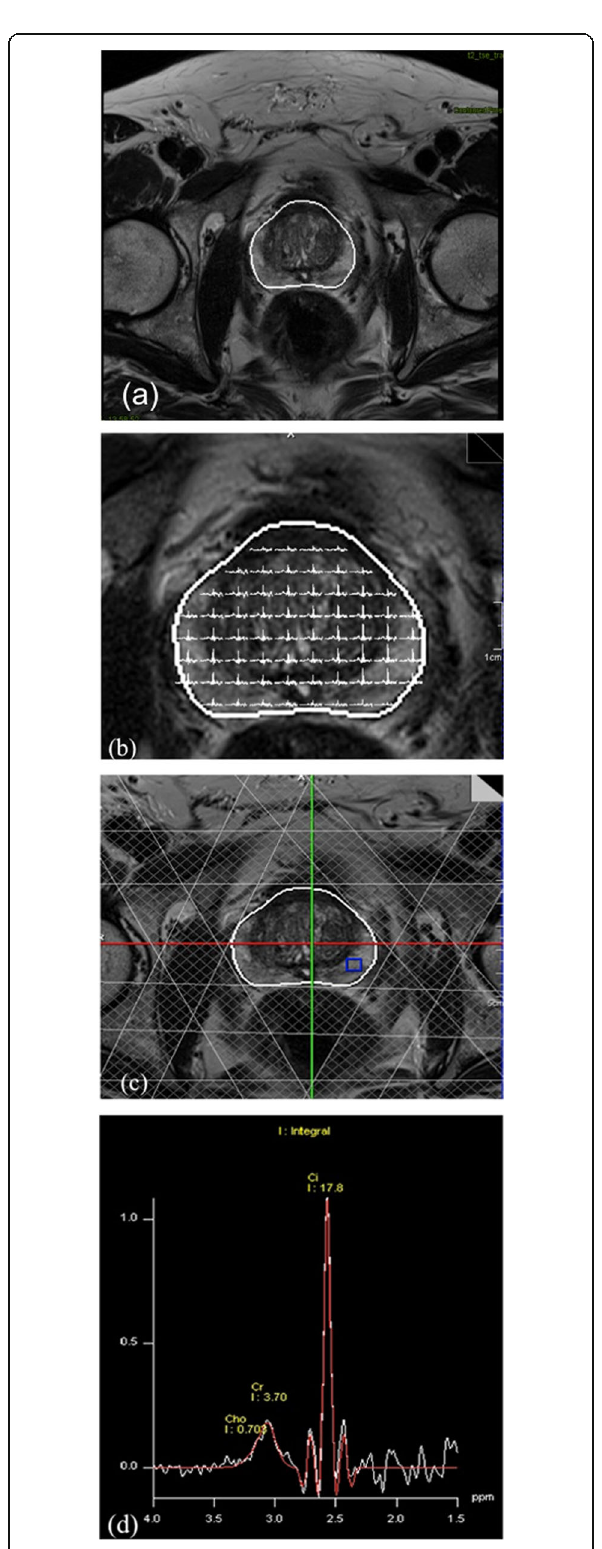
Fig. 2 Prostate spectroscopy with automatic DOT engine prototype. Automatic planning of saturation pulses, acquisition matrix, and field of view. Note precise delineation of the prostatic gland, which is seen within the automatic segmentation curve. a Axial image of the prostate gland with the surrounding white automatic segmentation curve precisely located at the margin of the prostate. b Axial image of the prostate gland showing all spectroscopic voxels inside the area delineated by the automatic segmentation curve. c Axial image of the prostate with saturation pulses around the prostate, which are accurately located at prostatic margins. d Sample spectrum of the mid-peripheral zone showing good diagnostic